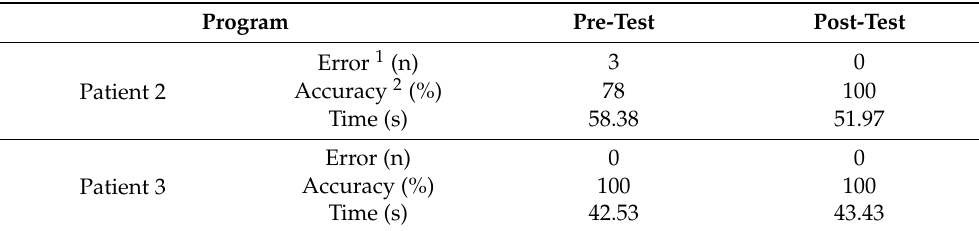
Table 1. Results based on the word practice program of Hangeul.